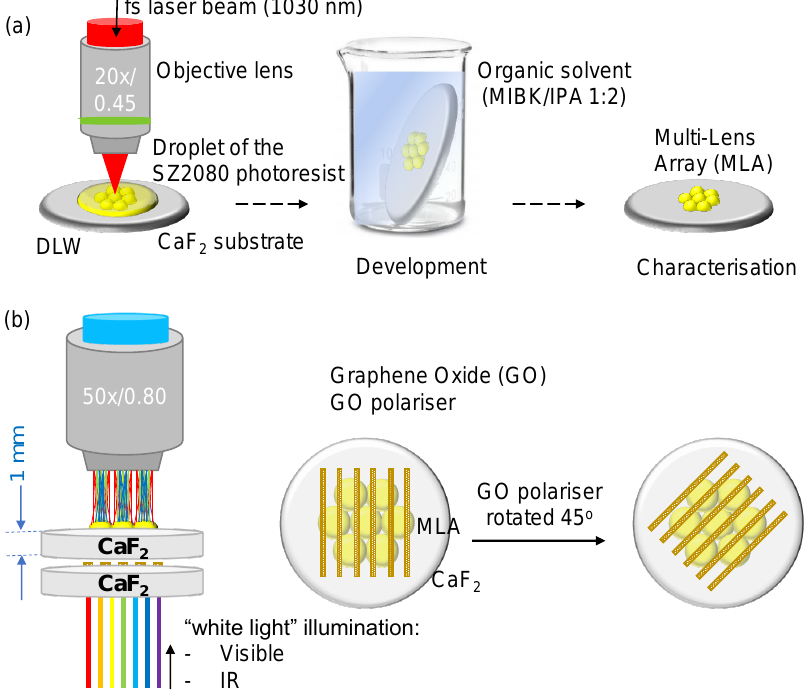
Figure 1. ( a ) Manufacturing steps in 3D DLW lithography. Pinpoint (maskless and selective) pho- topolymerisation by a tightly focused femtosecond pulsed laser beam. fs-DLW was carried out from the resist side due to the thick 1 mm CaF 2 substrate. Removal of unexposed volume by development in organic solvent (placing the sample with an angle to promote a cleaner development). Revelation of the fabricated MLA. ( b ) Optical characterisation of the micro-optical elements (lenses/arrays and GO polarisers) in the visible and IR spectral ranges; optical elements were made on a IR-transparent CaF 2